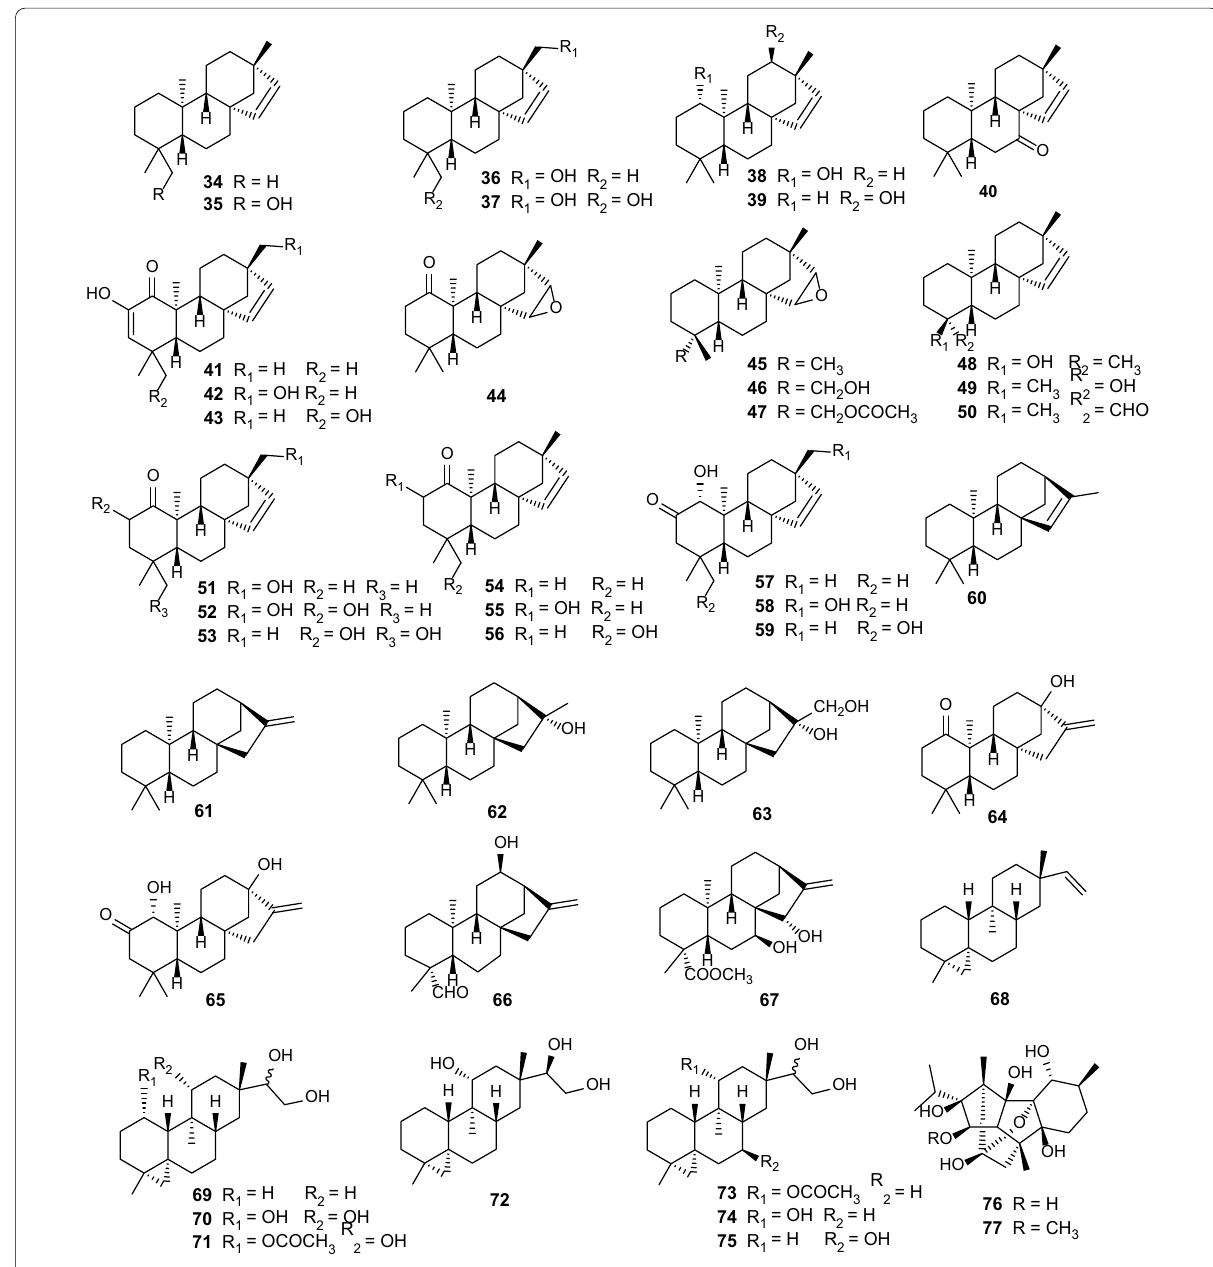
Fig. 4 Chemical structures of tetracyclic diterpenes ( 34–77 ) found in Erythroxylum